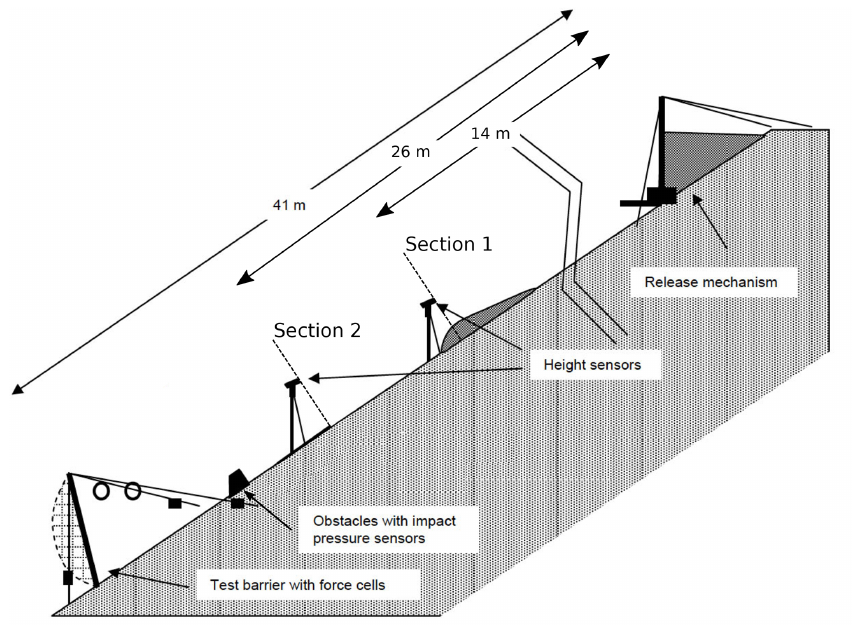
Figure 2. A schematic representation of the field experiment